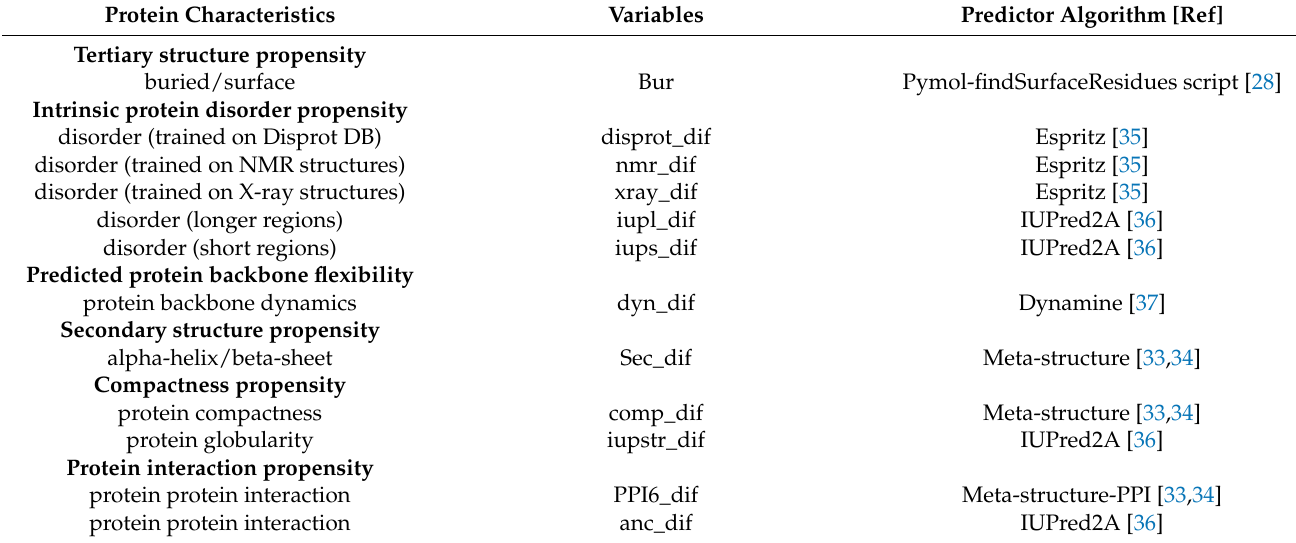
Table 1. Explanatory variables related to protein